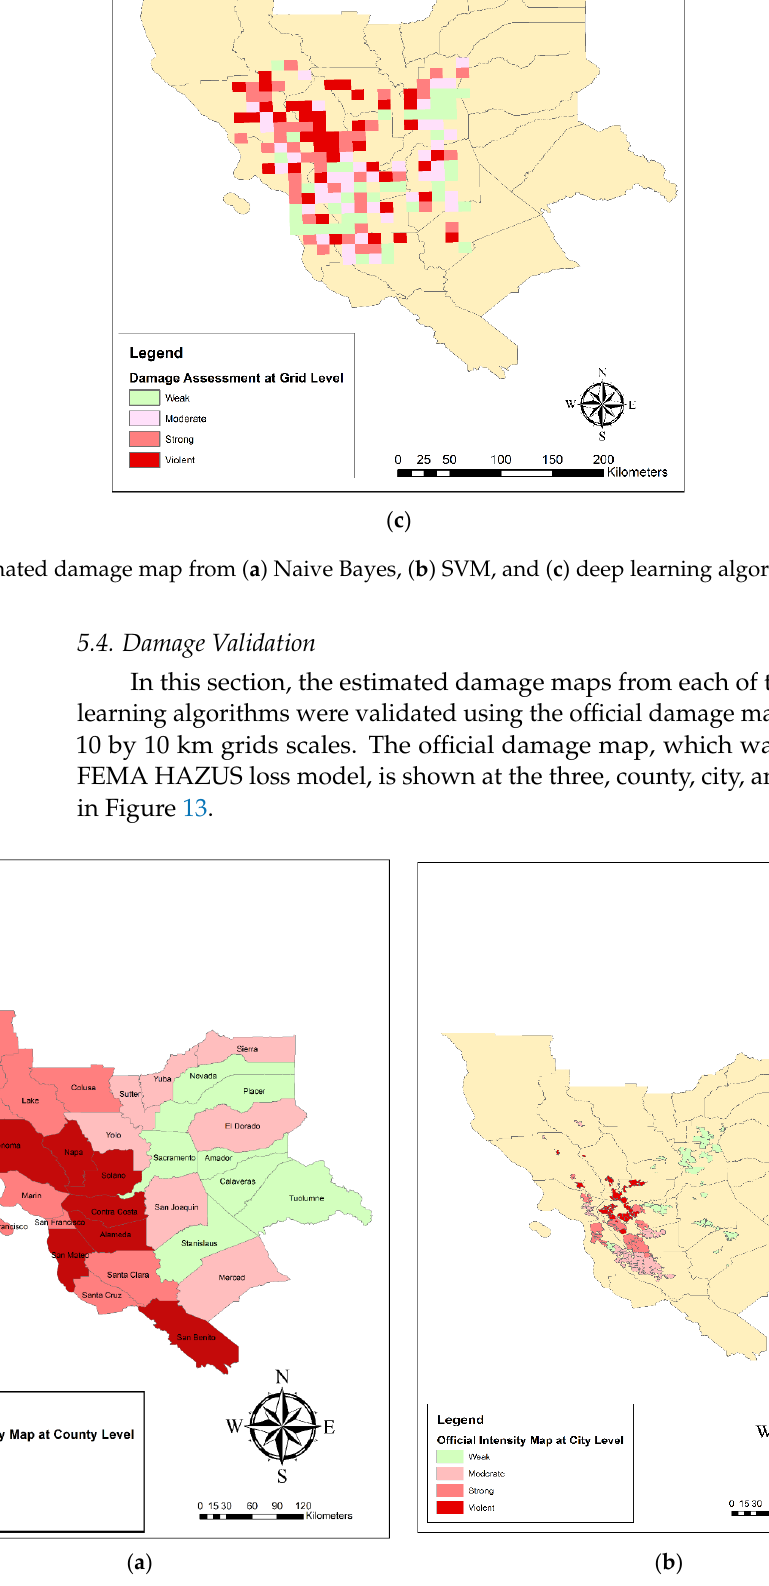
( c ) Figure 13. Official damage map at the county ( a ), city ( b ), and 10 by 10 km grids ( c ) scales. • Damage validation at the county scale